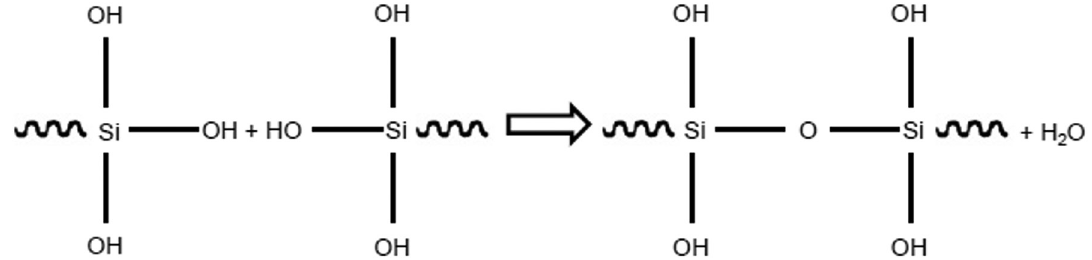
Scheme 2. Si-OH groups turn into oligomeric siloxane containing some unreacted Si OH by condensation